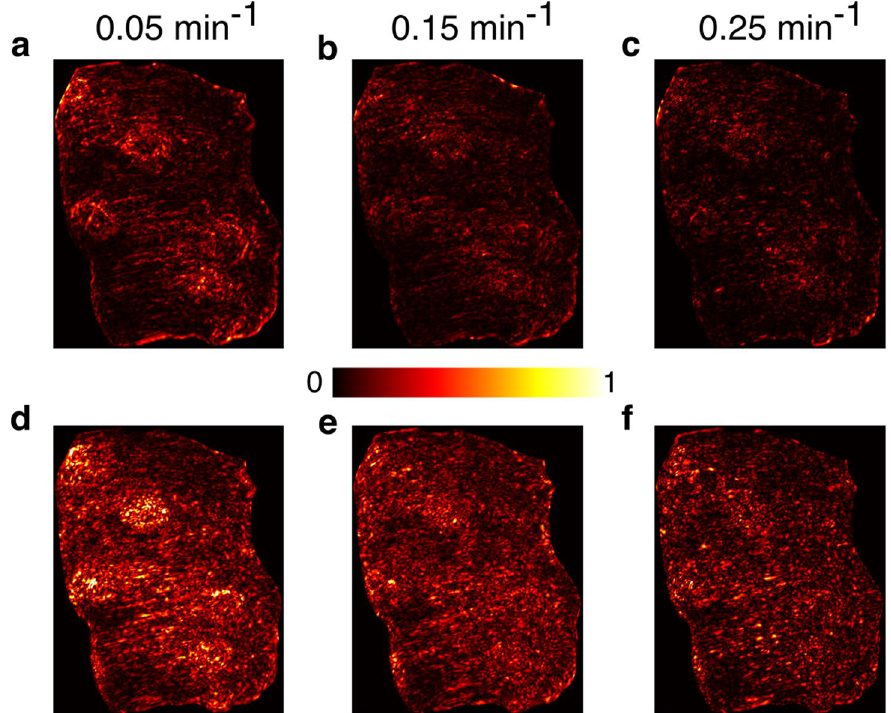
Figure 5. Mode shape of coral tissue motion during day and night. ( a–c ) Mode shapes of coral tissue motion during day at frequencies 0.05 min −1 , 0.15 min −1 and 0.25 min −1 , respectively. ( d–f ) Mode shapes of coral tissue motion during night at frequencies 0.05 min −1 , 0.15 min −11 and 0.25 min −1 ,